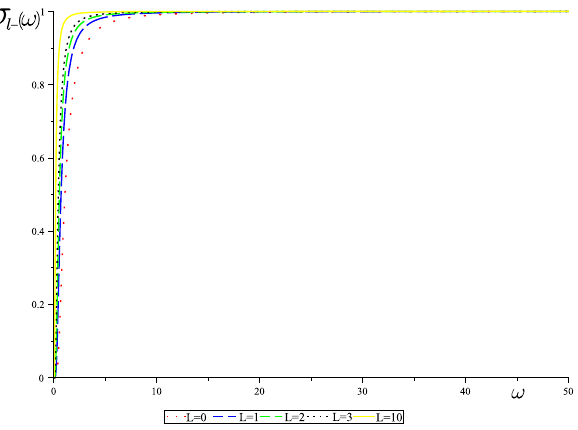
Fig. 6 Plotsof σ l − (ω) versus ω forthespin-( − 1 / 2 )particles.Thephys- ical parameters are chosen as; M = r = 1 , a = 0 . 03 and λ = − 1 .